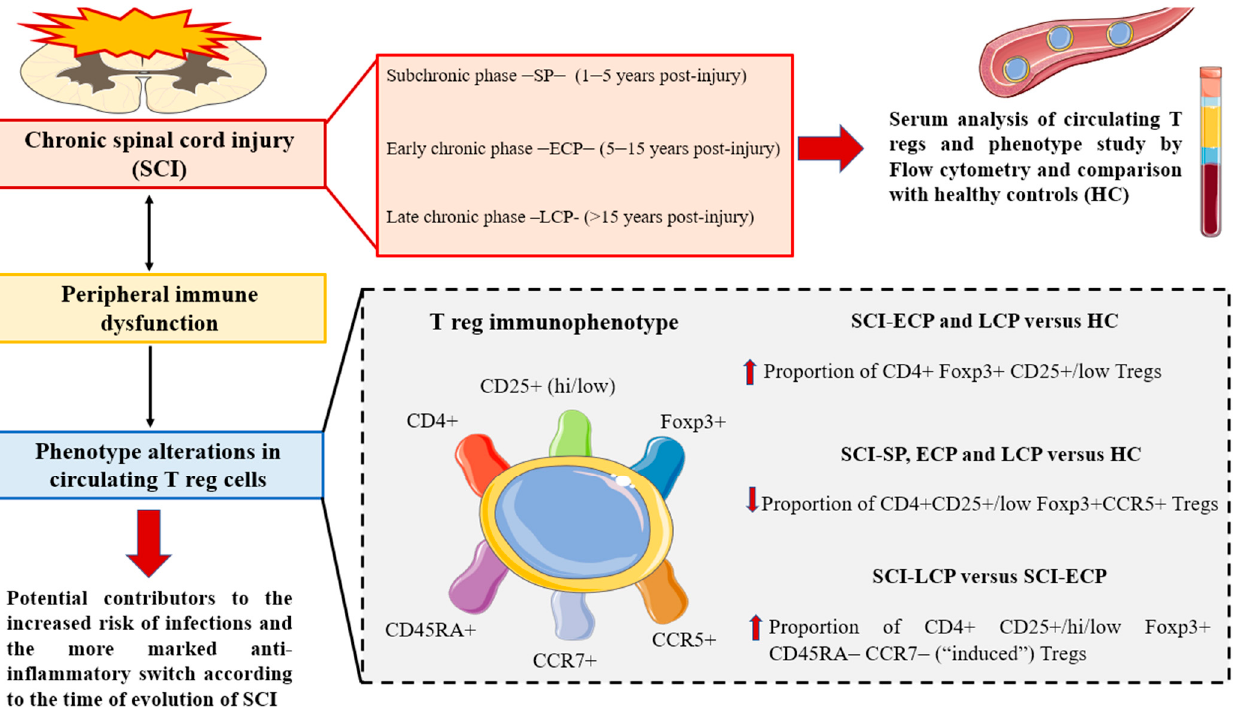
Figure 6. A summary of the main results compiled in the present work. Herein, the main phenotypic changes observed in patients with chronic SCI are summarized. Overall, there is a need for a deeper characterization of the immune dysfunction occurring in these patients, especially considering clinical correlates and variables.